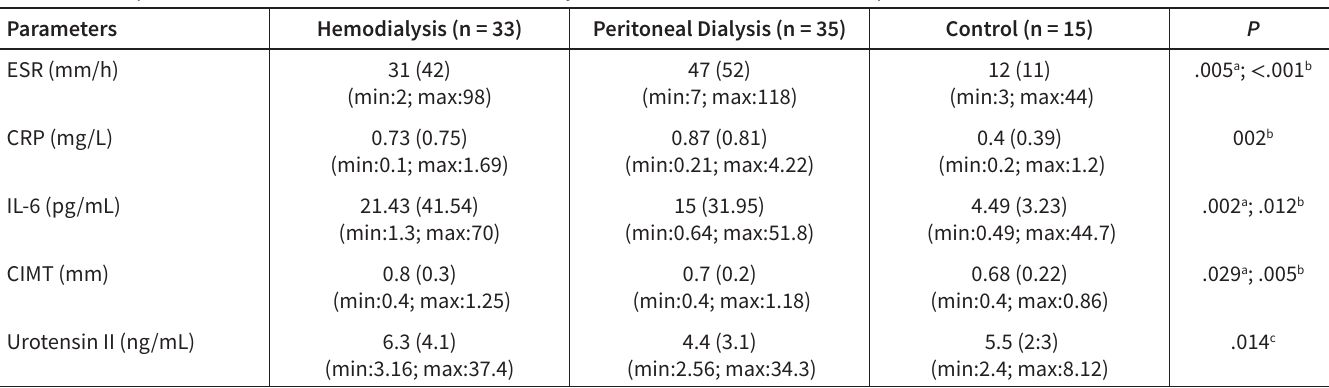
Table 1. Comparison of Basic Characteristics and Laboratory Parameters Between the 3 Groups ( Continued )